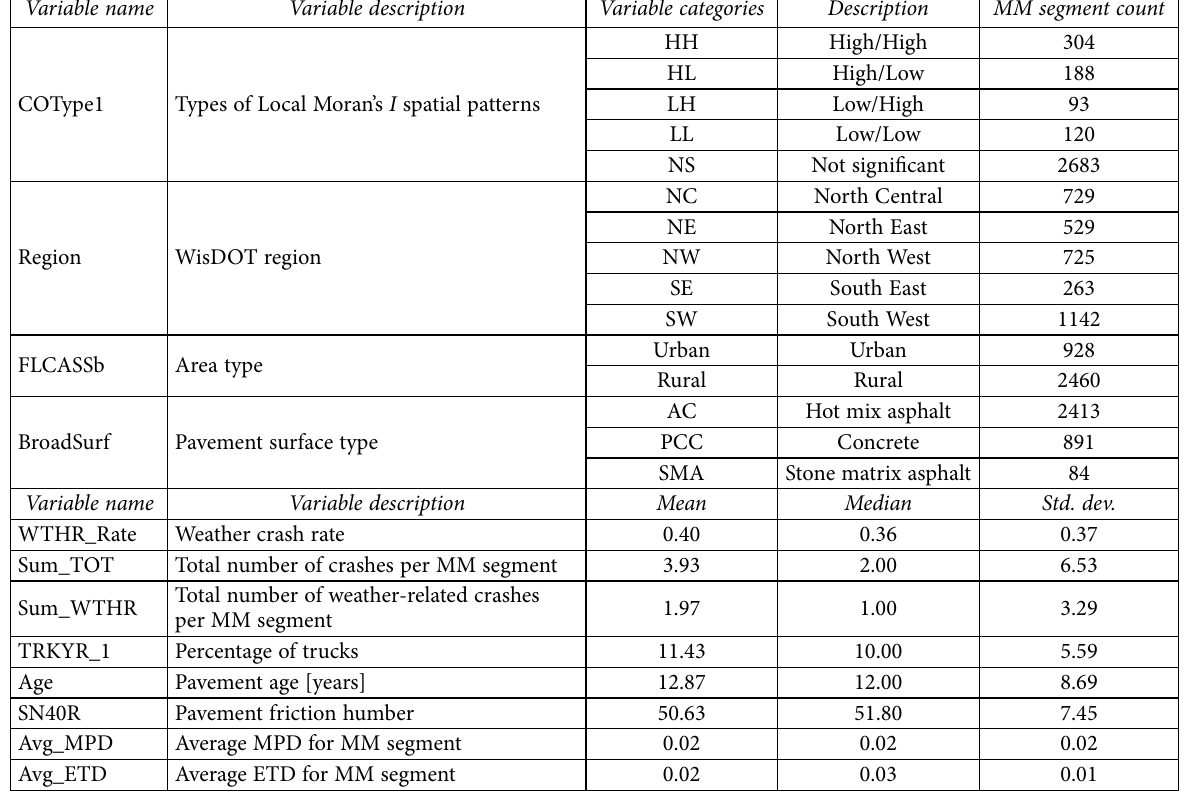
Table. Variables used in analysis of hotspots of weather-related crashes in